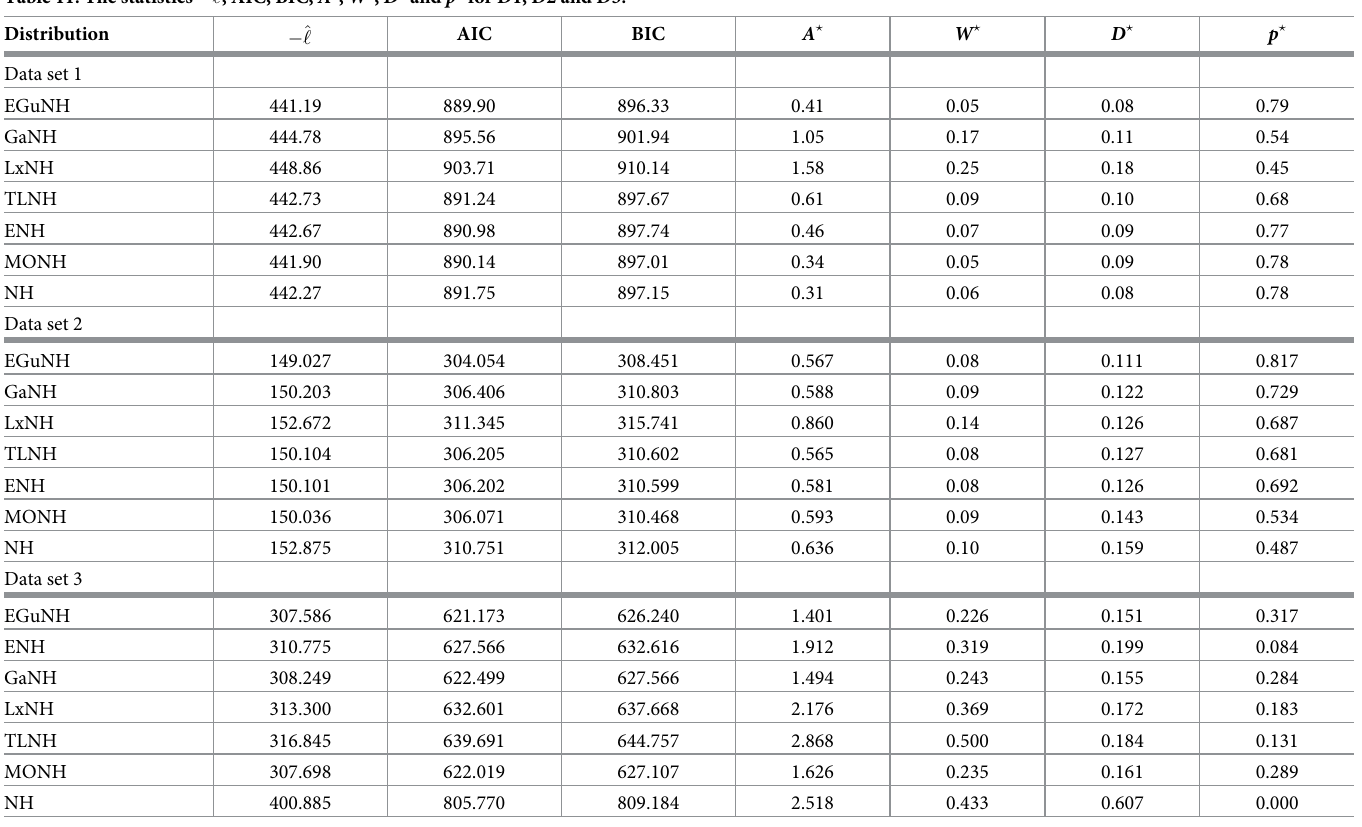
Table 11. The statistics (cid:0) ^ ‘ , AIC, BIC, A ? , W ? , D ? and p ? for D1, D2 and D3.